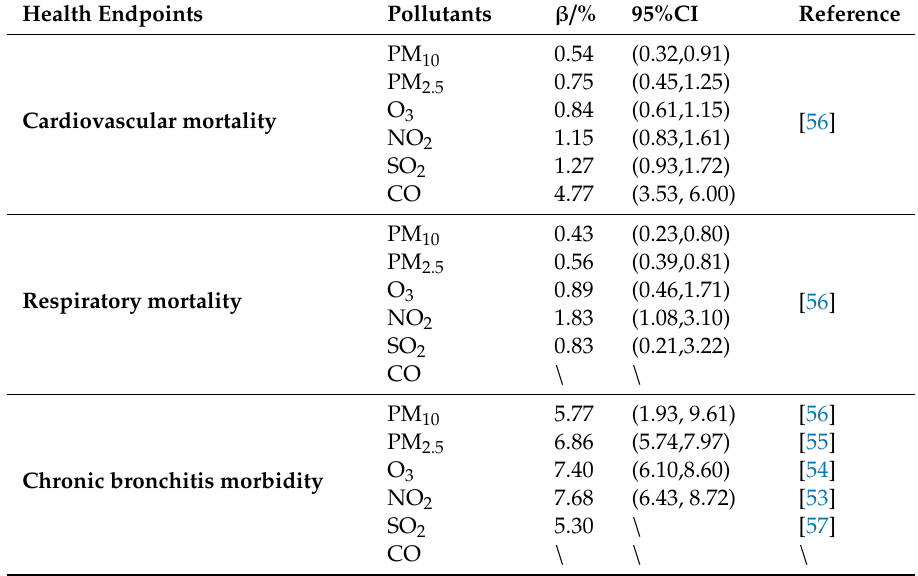
Table A2. Exposure–response coe ffi cients for human health damage by ambient pollution.